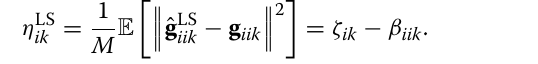
Figueiredo etal. EURASIPJournalonWirelessCommunicationsandNetworking (2018)